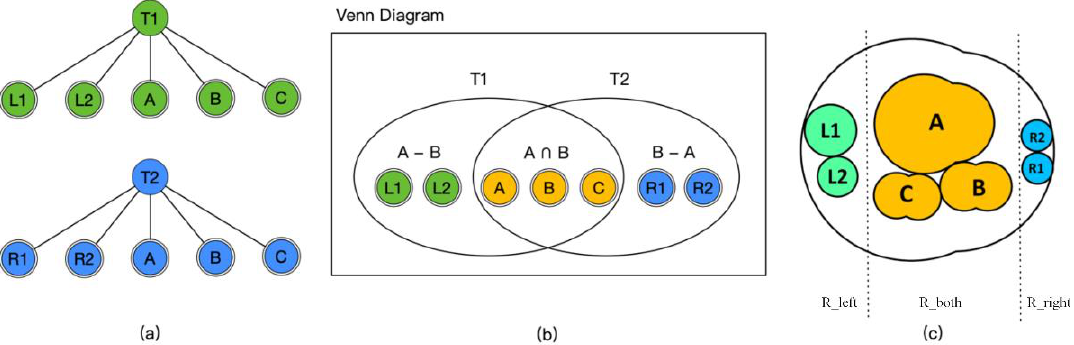
Figure 7. Shape mapping of merged nodes ( a ) Original subtrees of merged nodes. ( b ) Sub-node position in the Venn diagram. ( c ) Three regions in a merged node.